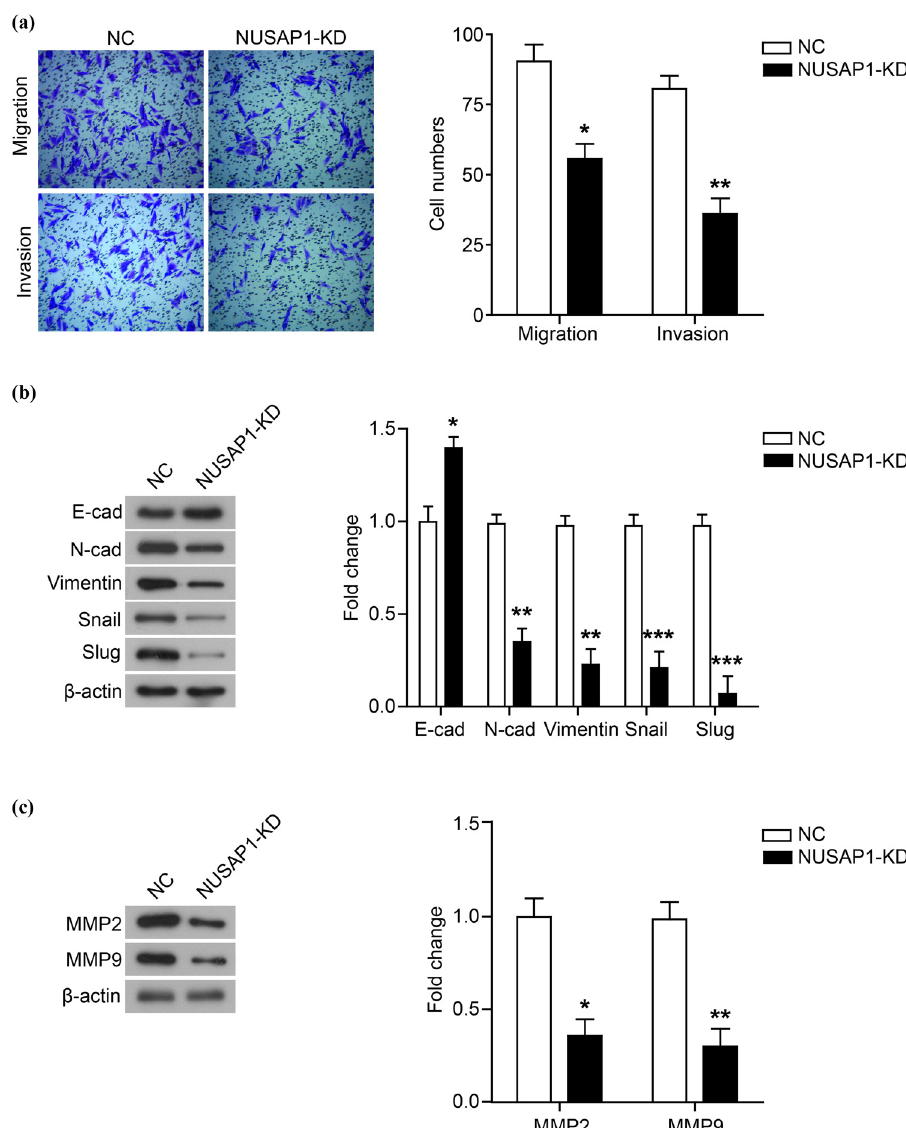
Figure 3: Knockdown of NUSAP1 represses the migration and invasion of MG63 cells. ( a ) The migration and invasion of MG63 cells whose NUSAP1 expression was knocked down ( NUSAP1 - KD ) under normoxia condition was measured using transwell assay. ( b ) The expression of EMT - related proteins was detected using western blot. ( c ) The expression of MMP family membranes was detected using western blot. All experiments were independently carried out in three replicates. * P < 0.05, ** P < 0.01, *** P < 0.001, compared with NC